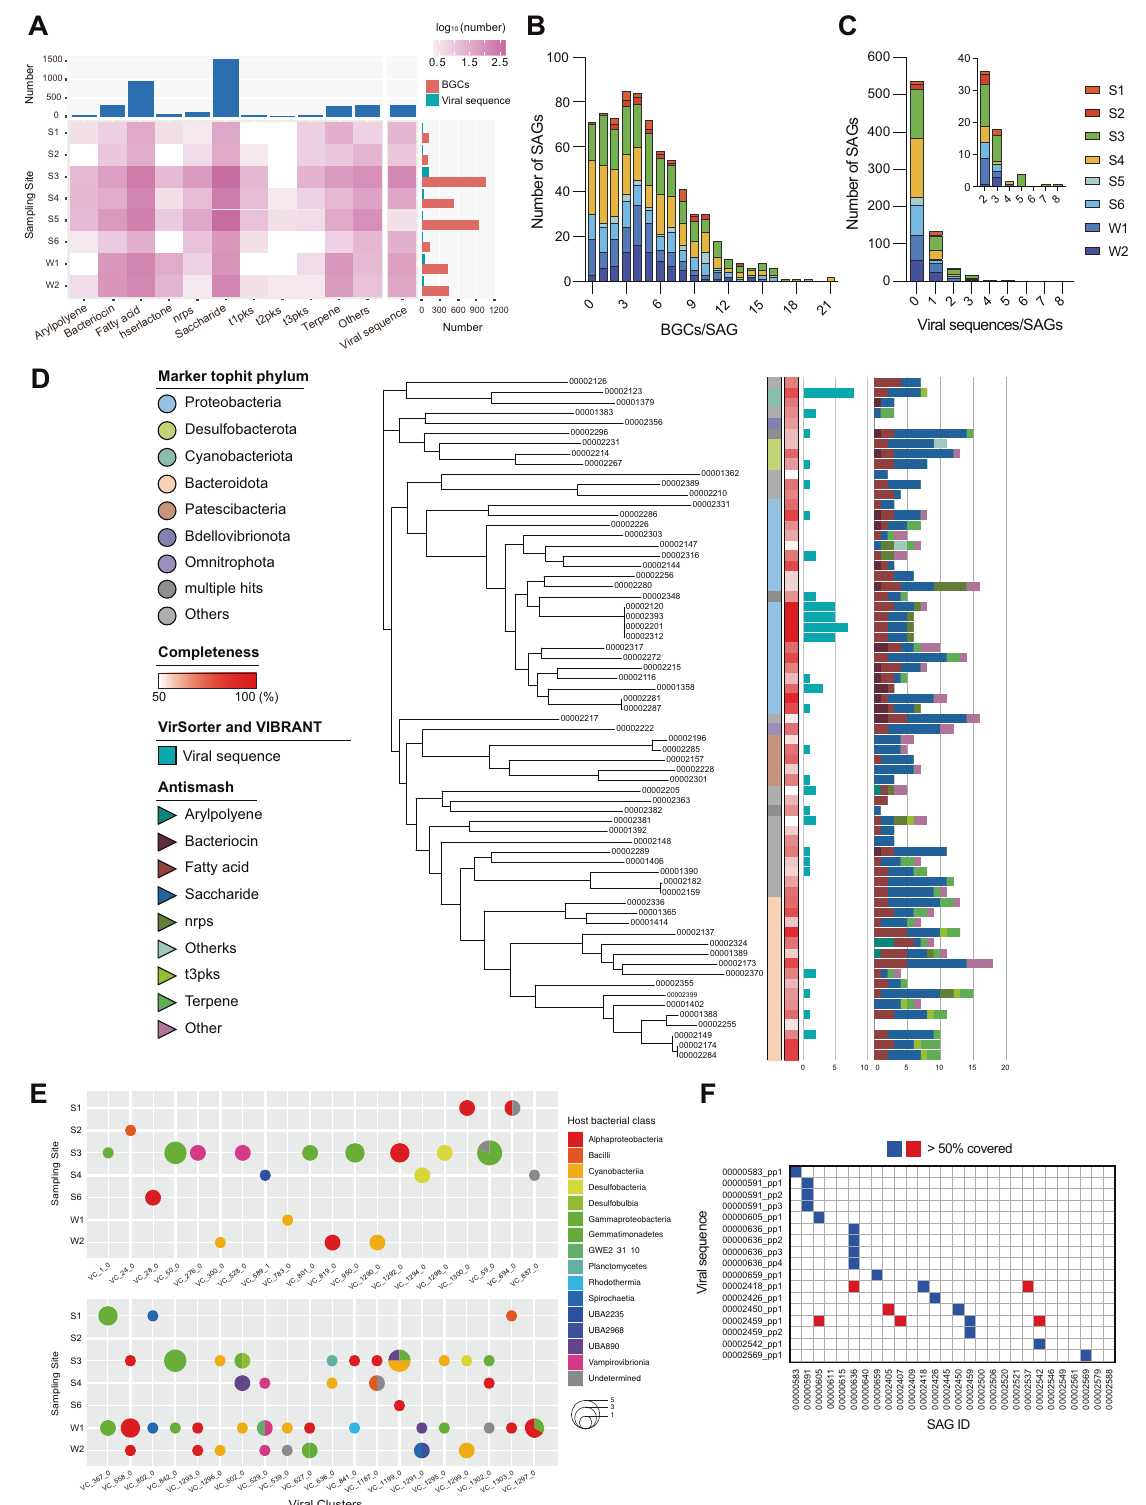
DNA quanti fi cation and 16S rRNA gene PCR The amplicon yields of the 2nd-round WGA were quanti fi ed using a Qubit dsDNA HS assay kit (Thermo Fisher Scienti fi c). To estimate the samples derived from bacteria, 16S rRNA gene PCR and agarose electrophoresis (100 V, 15 min) was performed against the WGA